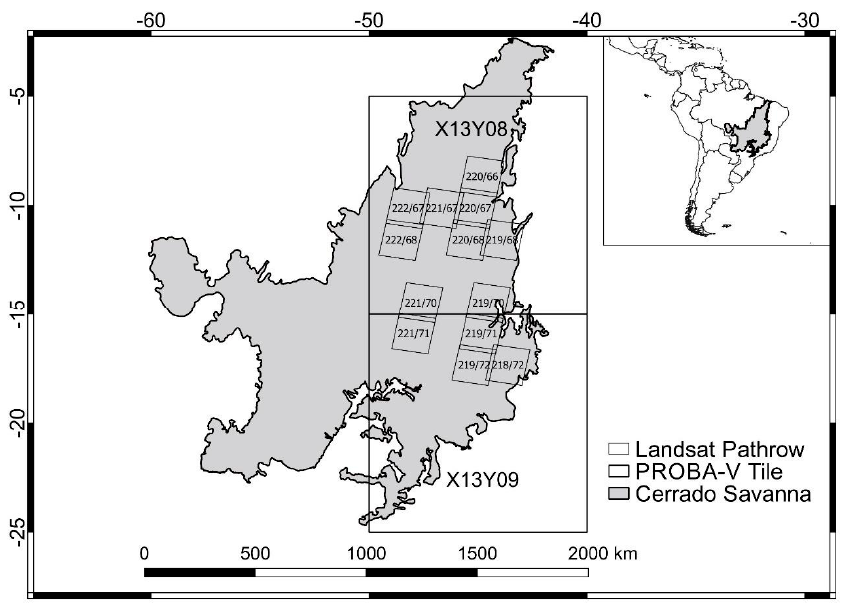
Figure 1. Location of the Cerrado savanna biome in South America ( upper right ), the study area ( center ) outlined by the two Project for On-Board Autonomy-Vegetation (PROBA-V) tiles (X13Y08/09) and the 13 Landsat 8 reference scenes (with path/rows) also shown.